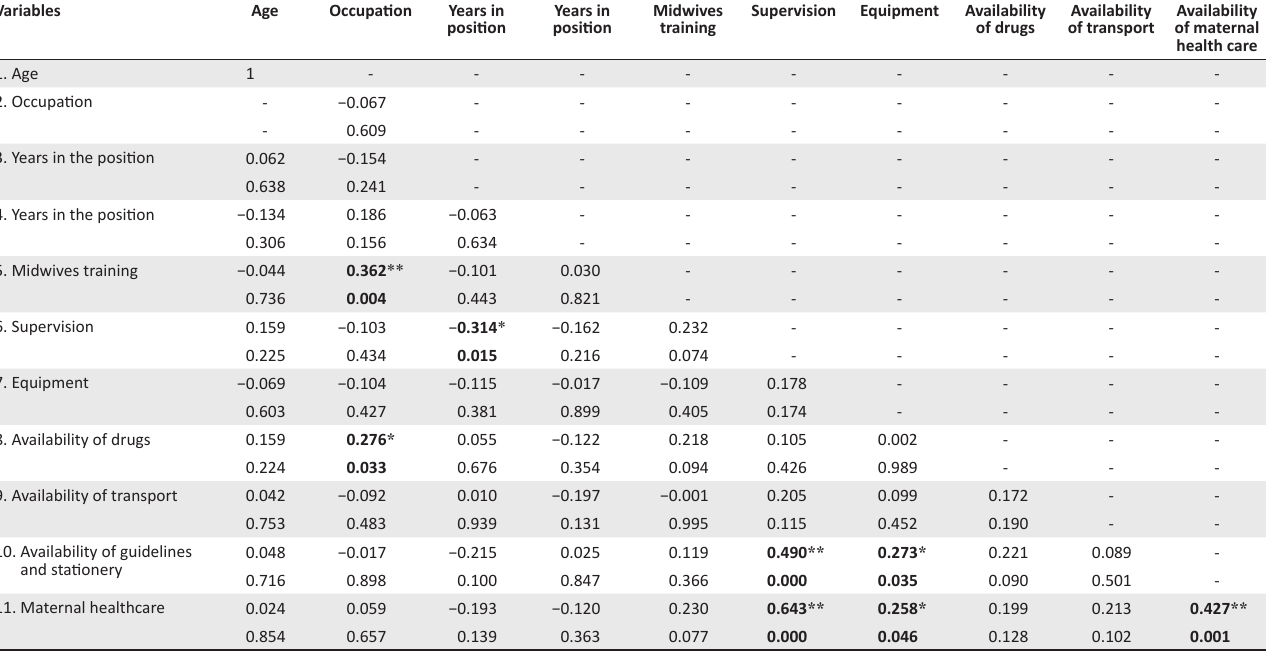
TABLE 4: Correlations.